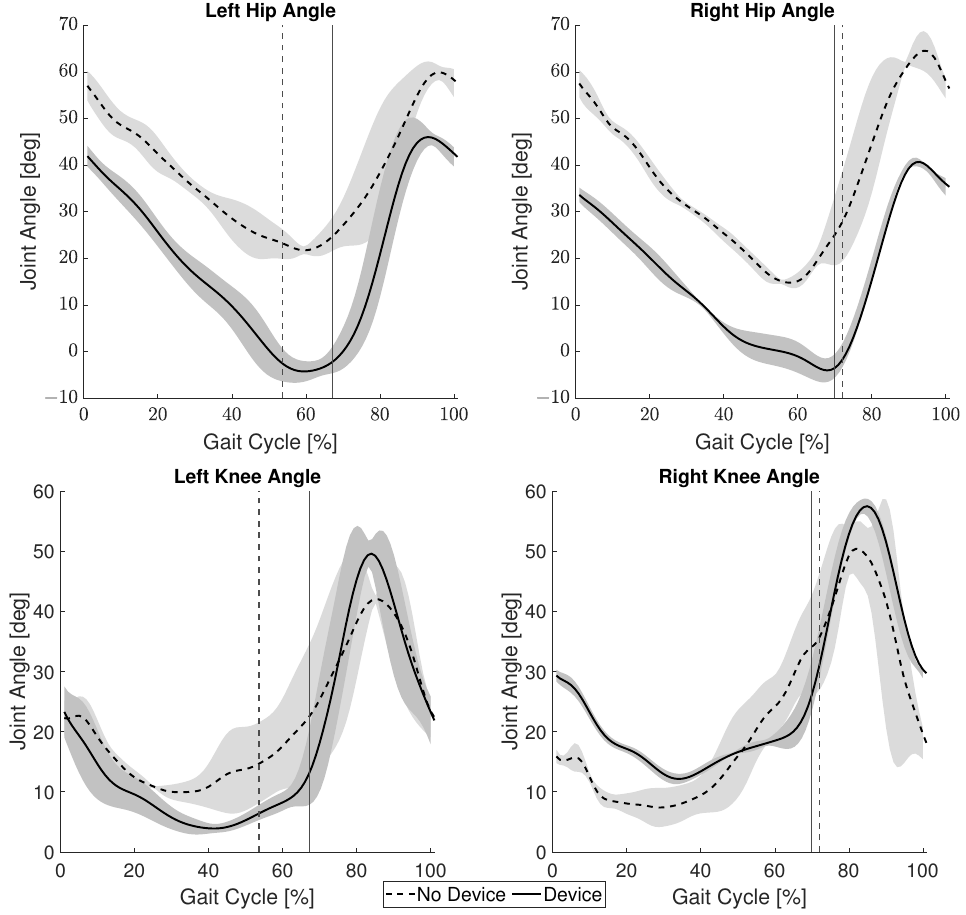
Figure 12. Joint angles of the individual with CP. Vertical lines represent the end of the stance